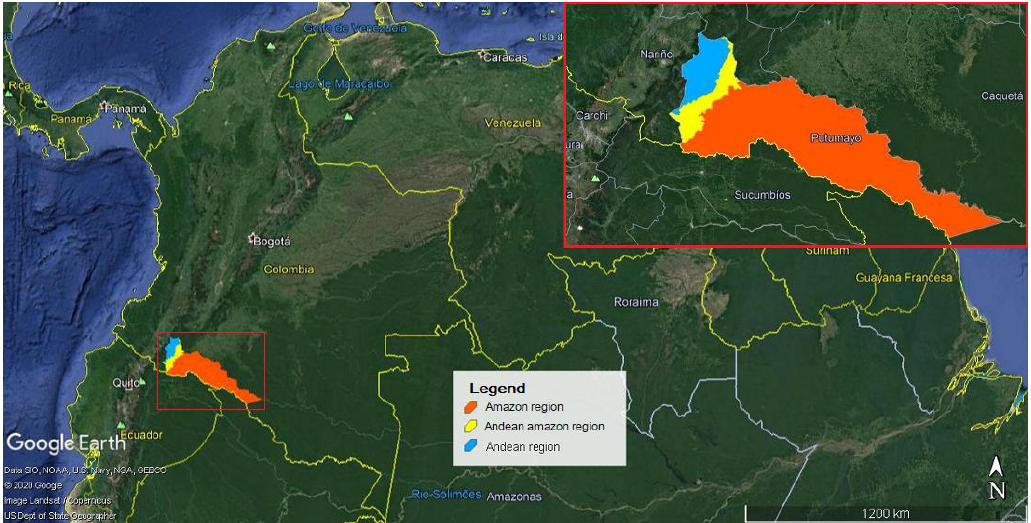
Figure 1. Location of the department of Putumayo and the Andean, Andean-Amazon, and Amazon regions.